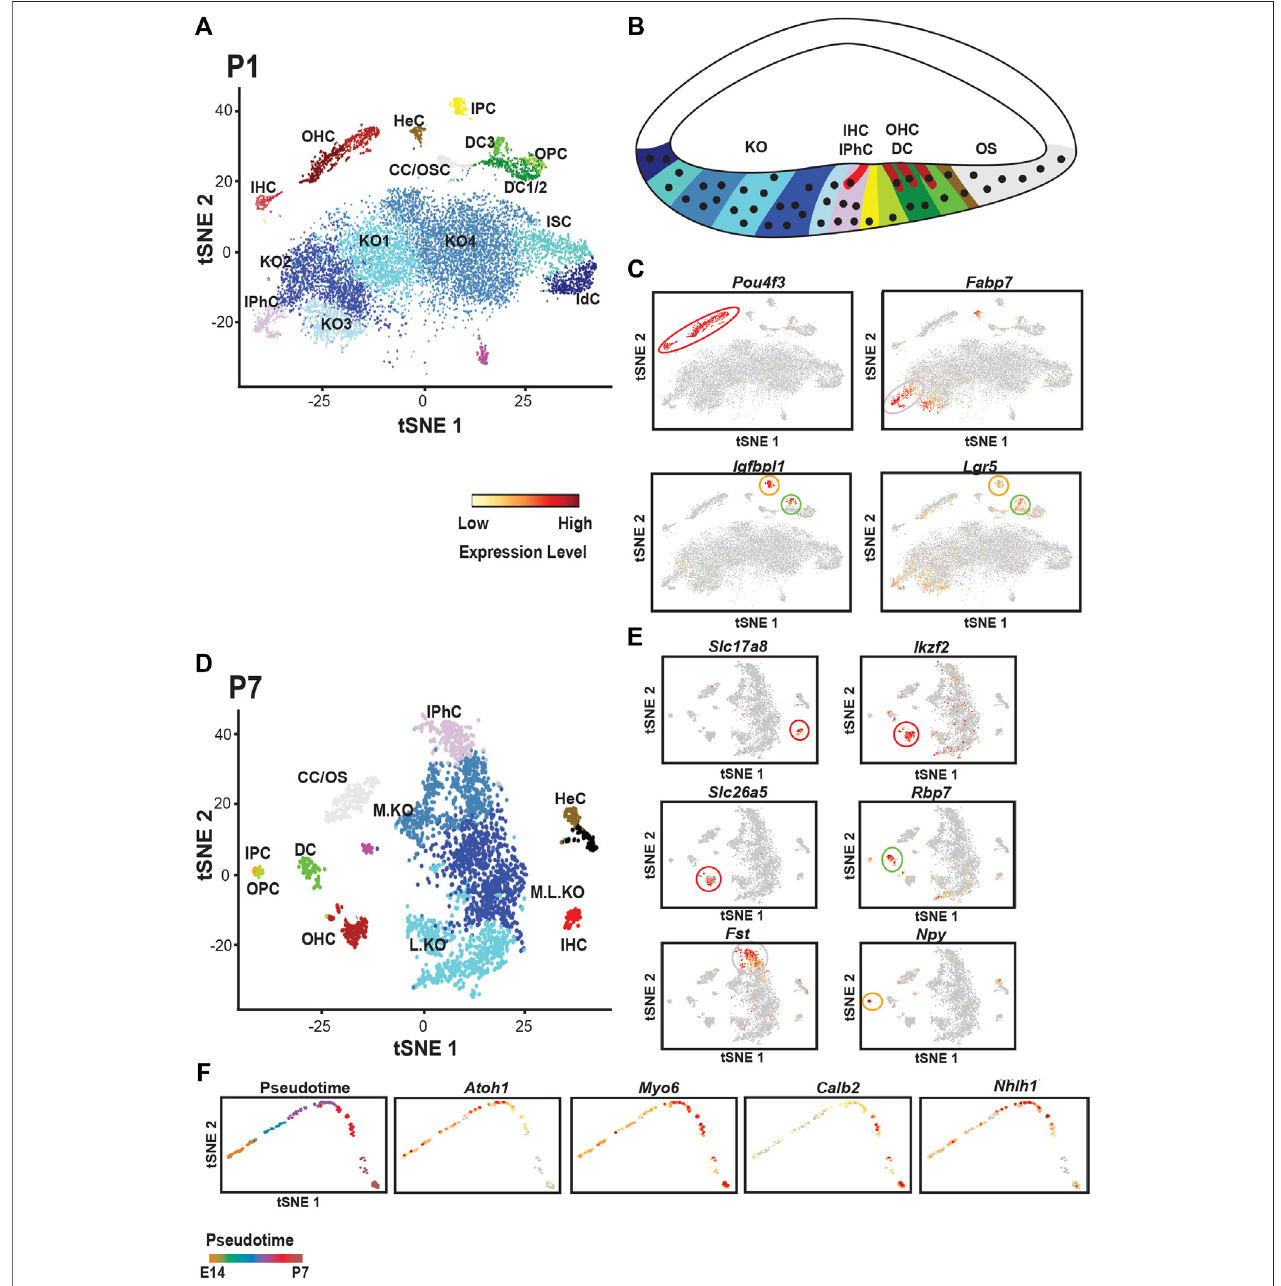
FIGURE 4 | Single cell analysis of cochlear development at P1 and P7. (A) tSNE plot for single cells collected from the fl oor of the cochlear duct at P1. All of the knowncell types withinthe organ ofCorti canbe identi fi ed ascanHensen ’ sand Claudius ’ cells (HeCand CC). In addition, multiple transcriptionally distinct cell types are identi fi edinKolliker ’ sorgan(KO1-4),Interdentalcells(IdC)andInnerSulcuscells(ISC)). (B) SchmaticofthecochlearductatP1withpositionsofcellsfromAindicatedby color. The basic pattern within the organ of Corti is present although many of the supporting cells have not fully differentiated at this time point. (C) Feature plots illustrating expression of marker genes for hair cells ( Pou4f3 ), inner phalangeal cells ( Fabp7 ), and inner pillar cells/Deiters ’ cells ( Igfbp1 and Lgr5 ). (D) tSNE plot for cochlearsinglecellscollectedatP7.AllofthecelltypeswithintheorganofCorticanbeidenti fi ed.Innerandouterpillarcells(IPC,OPC)areverysimilartranscriptionally,a change from P1. In addition, all three rows of Deiters ’ cells cluster together suggesting that the transcriptional differences between Deiters ’ cells in rows one and two versus three at P1 may be a result of differences in the timing of their development. In contrast with P1, the number of unique cell clusters in Kolliker ’ s organ has decreased tothree. Forrelativepositions of different cells types in thecochlea, refer to Figure 1B . (E) Feature plots illustrating marker genesfor different cell types in the organ of Corti at P7. Slc17a8 marks IHCs while OHCs express Ikzf2 and Slc2615 ( Prestin ). Deiters ’ cells uniquely expressed the retinol binding protein Rbp7 , inner phalangeal cells express Fst and inner pillar cells express Npy . (F) Pseudotime projection for developing OHCs collected from all four time points (E14, E16, P1 and P7). Color coding in upper left panel indicates relative age across the pseudotime projection from E14 to P7. All other panels show expression of speci fi c genes across pseudotime(seescalebarin4C). Atoh1 isdown-regulatedashaircellsdevelop, Myo6 and Calb2 areup-regulatedashaircellsmatureandthetranscriptionfactor Nhlh1 shows transient expression. All tSNE and feature plot images were generated using gEAR (umd.gear).